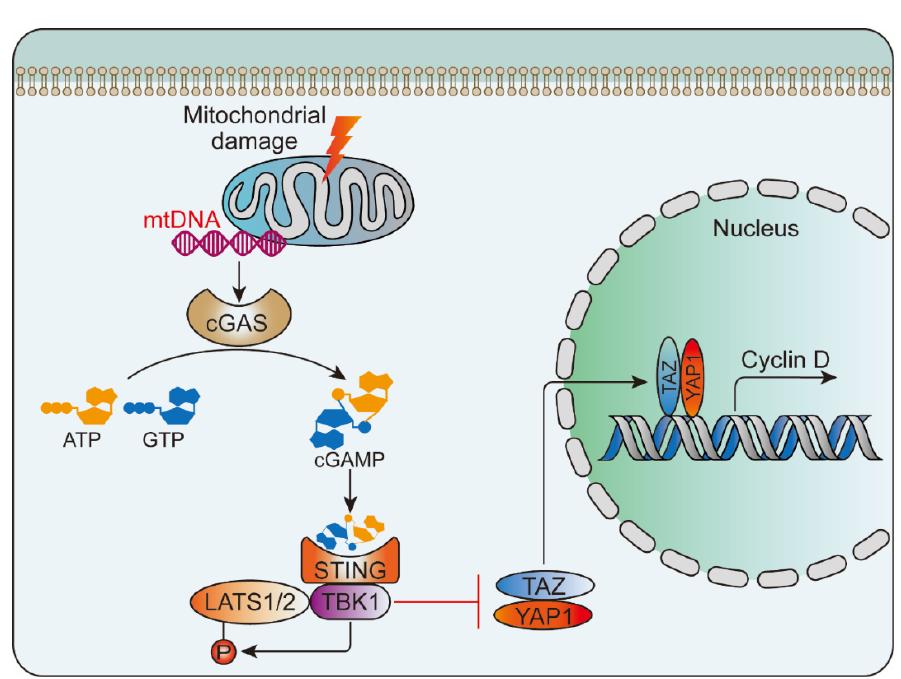
Figure 4. mtDNA-triggered cGAS-YAP pathway. mtDNA was released from the damaged mitochondria and then activated the cGAS-STING signaling pathway, which inhibited the nuclear translocation of YAP1 and inhibited cyclin D mediated endothelial proliferation. STING, stimulator of interferon genes; TBK1, TANK-binding kinase 1; LATS1/2, large tumor suppressor kinase 1/2; TAZ, transcriptional coactivator with PDZ-binding motif.4.3.2. Adenosine triphosphate.